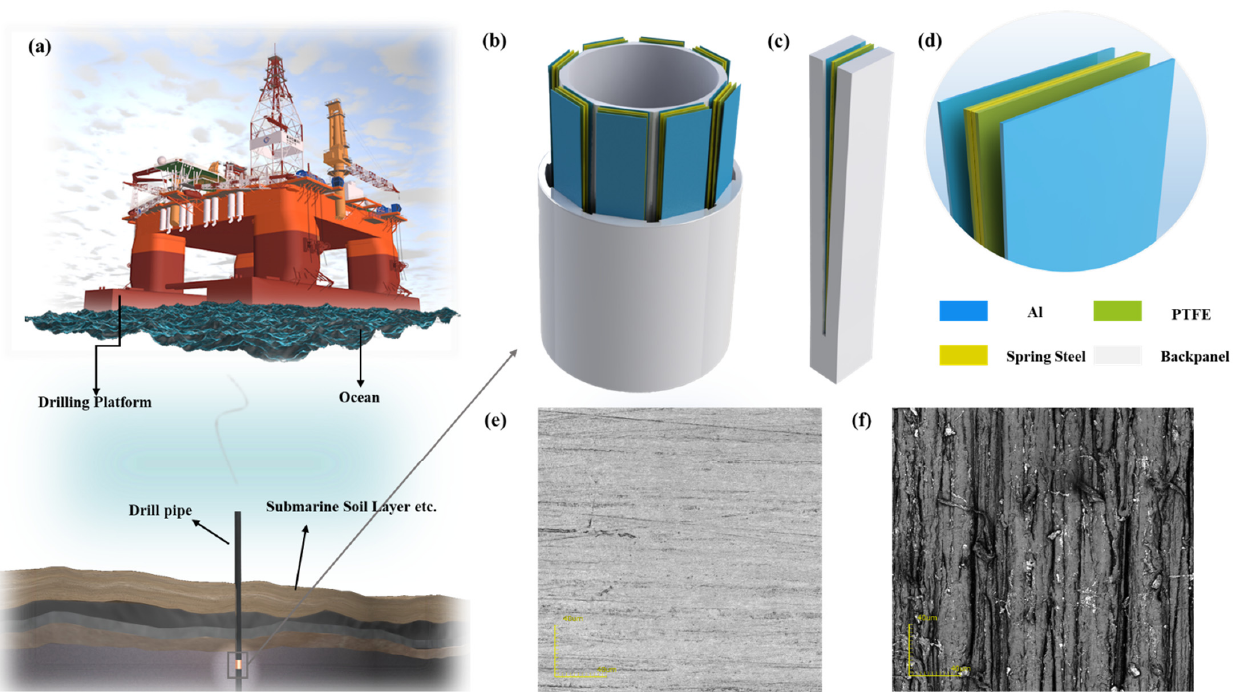
Figure 2. Application scenario and structure of CB-TENG device ( a ) Application of CB-TENG in vibration energy collection of drill pipe for offshore oil extraction; ( b ) the structure of array-type CB-TENG; ( c ) the composition of CB-TENG; ( d ) the partial enlargement of the tip of CB-TENG; ( e ) SEM image of PTFE surface (Not sanded); ( f ) SEM image of sanded PTFE surface.